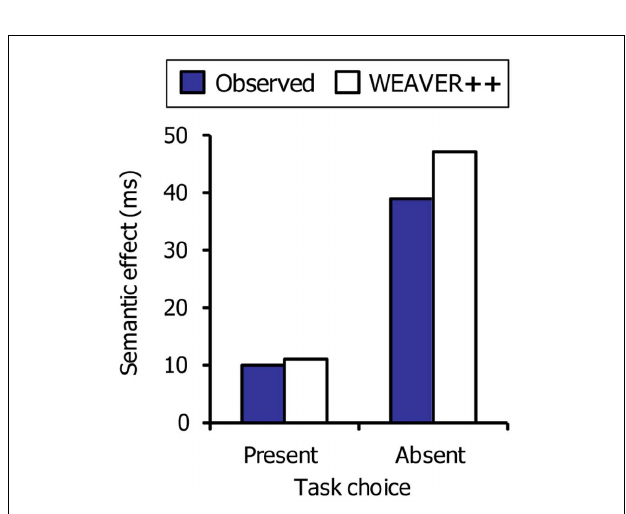
FIGURE 8 |The semantic interference effect in picture naming as a function of the presence or absence of a task choice. Shown are the real data (Piai et al., 2011) andWEAVER ++ simulation